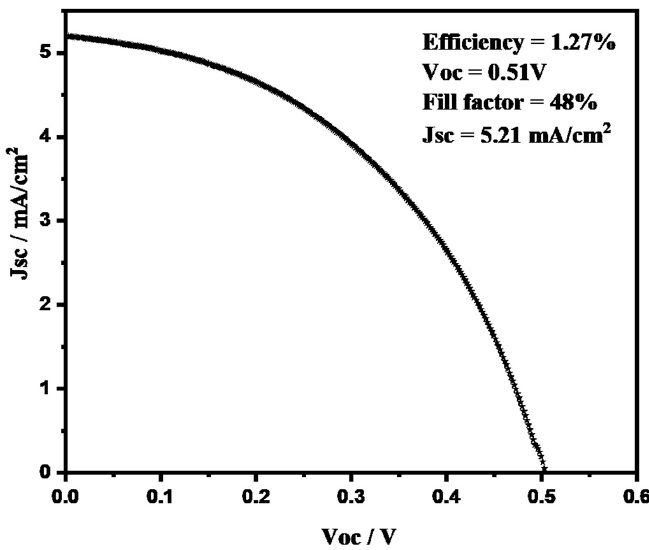
Figure 7. J–V response of the fabricated MA 3 Sb 2 I 9 based Pb 2+ free